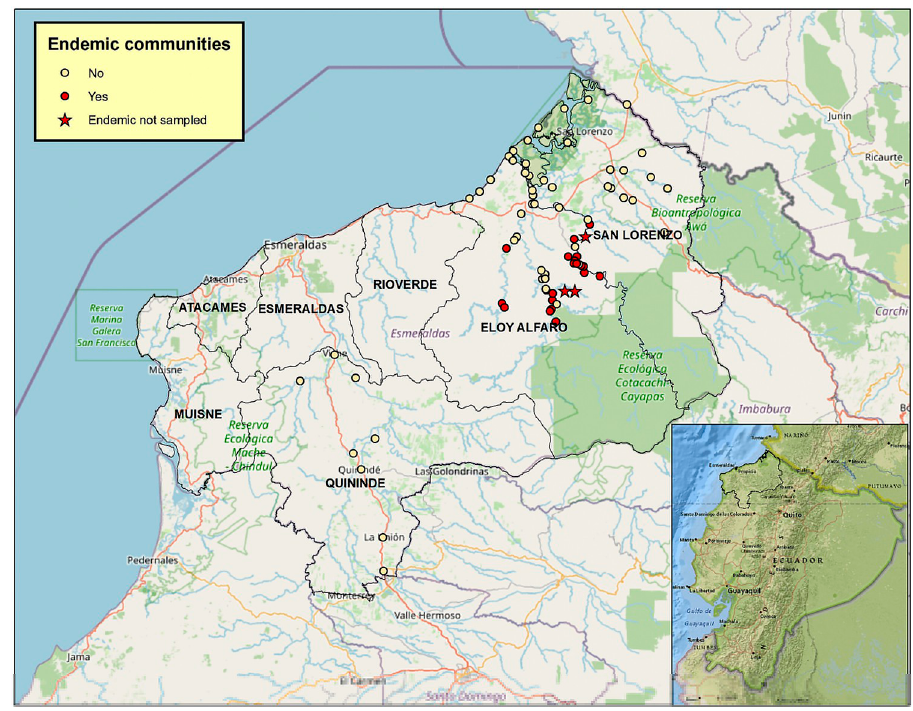
Fig 1. Map of formerly endemic and non-endemic sample communities in Esmeraldas Province. Shown are locations of formerly endemic (red circles) and non-endemic (yellow circles) communities, and formerly endemic communities not sampled (red stars). The map was built using ArcGIS version 10.2.2 (ESRI, California, USA).